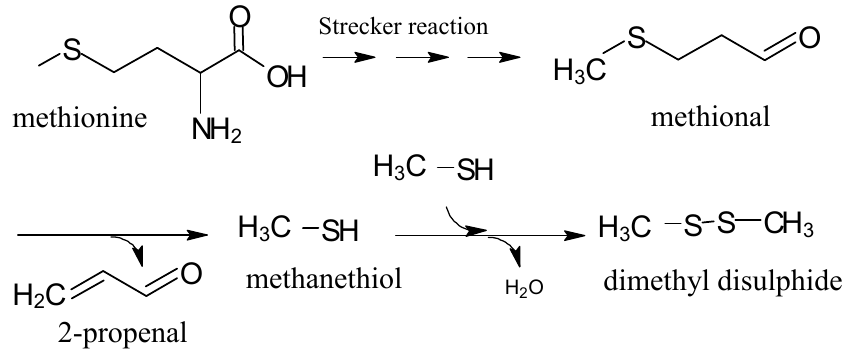
Scheme 9. Degradation of methionine to methional, methyl mercaptan (or